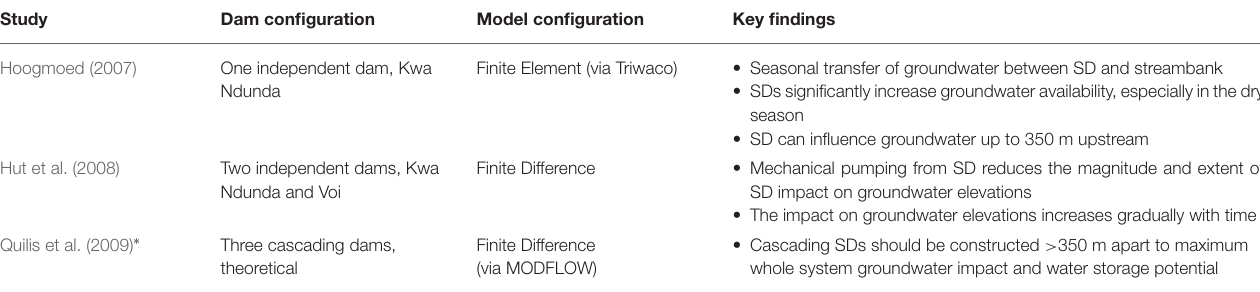
TABLE 2 | Sand dam subsurface flow